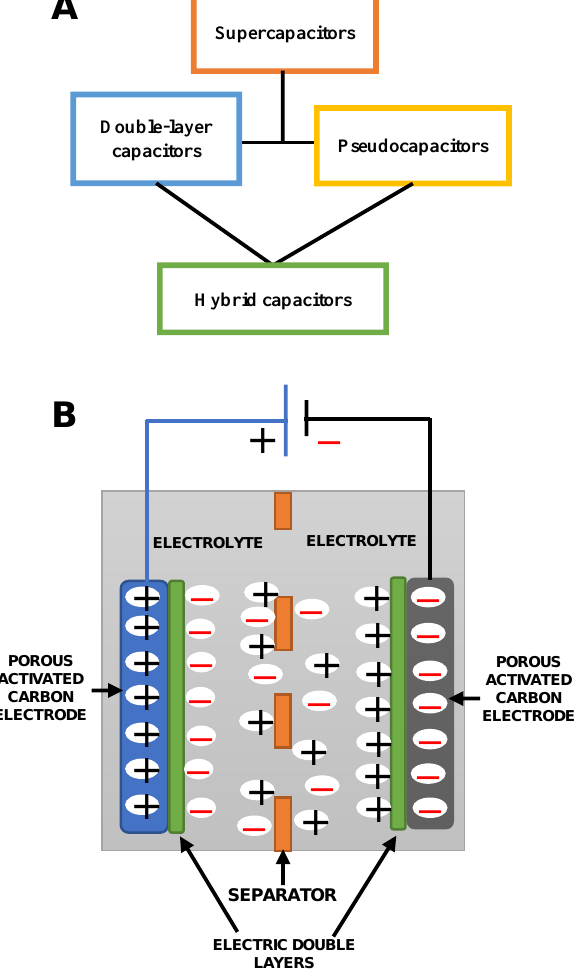
Figure 2. Schematic of ( A ) types of supercapacitors and ( B ) electrical double layer.